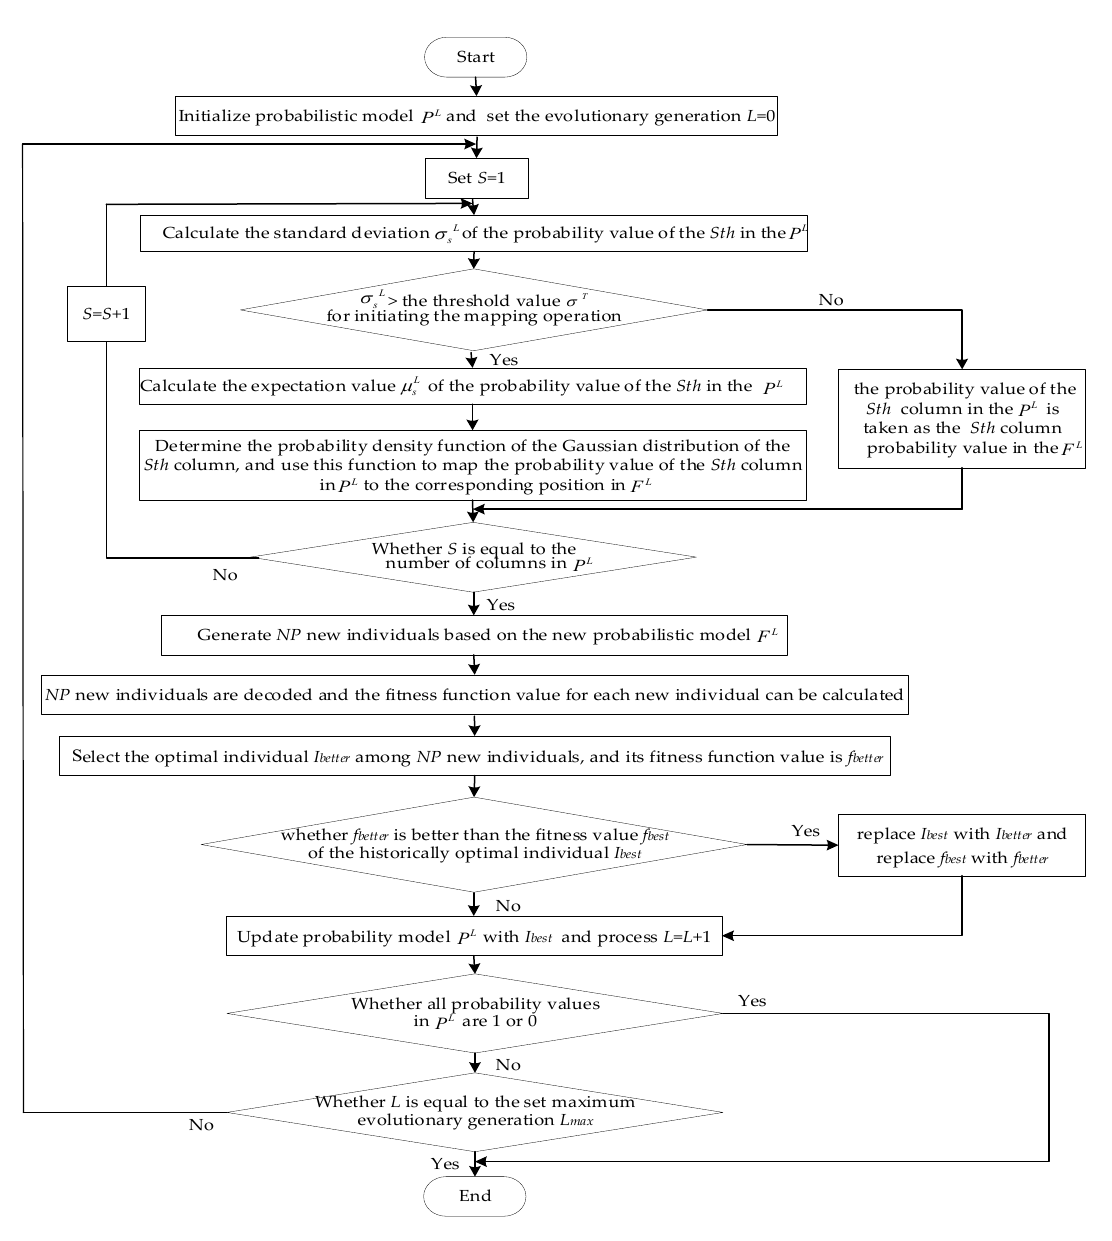
Figure 2. The flowchart of ICGA.